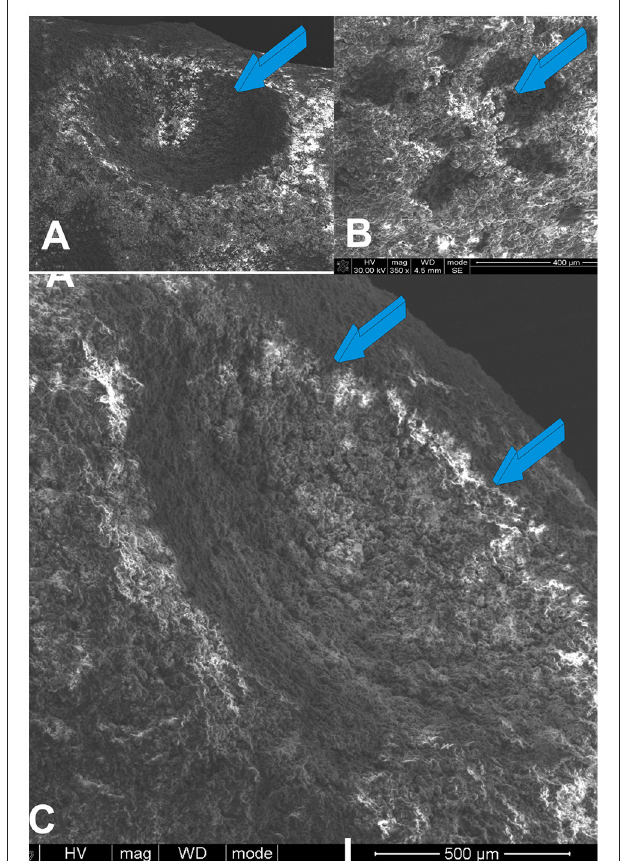
FIGURE 4 | Molecular, morphological and biological conceptualization of the role of the concavity to construct intrinsically osteoinductive hydroxyapatite-coated titanium implants for the spontaneous induction of bone formation. (A) Substantial induction of bone formation (light blue arrow) by highly sintered highly crystalline hydroxyapatite bioreactors implanted in the rectus abdominis muscle of the Chacma baboon Papio ursinus ( Ripamonti et al., 1999). (B) Alignment and orientation of MC 3T3-E1 pre-osteoblastic cells within a concavity (light blue arrow) of the coral-derived bioreactor in vitro (Ripamonti et al., 2012a). (C) Digital image of a macroporous sintered hydroxyapatite resembling the tread of an implant implanted heterotopically yet spontaneously inducing bone (light blue arrows) within the concavities of the bioreactor in close relationship with invading capillaries (magenta arrows). (D) The “ concavity motif, ” the “ concavity: the shape of life ” (Ripamonti, 2006; Ripamonti et al., 2012a) is then re-assembled in a titanium construct prepared with concavities along the substratum later coated by highly crystalline plasma sprayed sintered hydroxyapatite onto the prepared titanium surface (Ripamonti et al., 2012a). Light blue arrows (D) indicate the adsorption within concavities of plasma products during the surgical implantation in orthotopic mandibular and tibial sites (Ripamonti et al., 2012a).